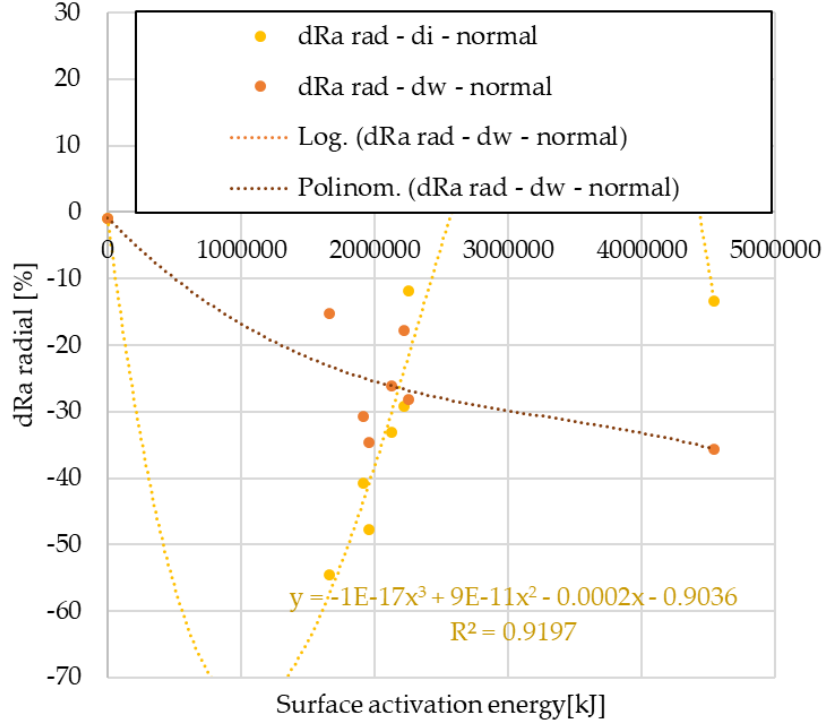
Figure 12. Variation of radial Ra values as a function of activation energy — normal use facings.